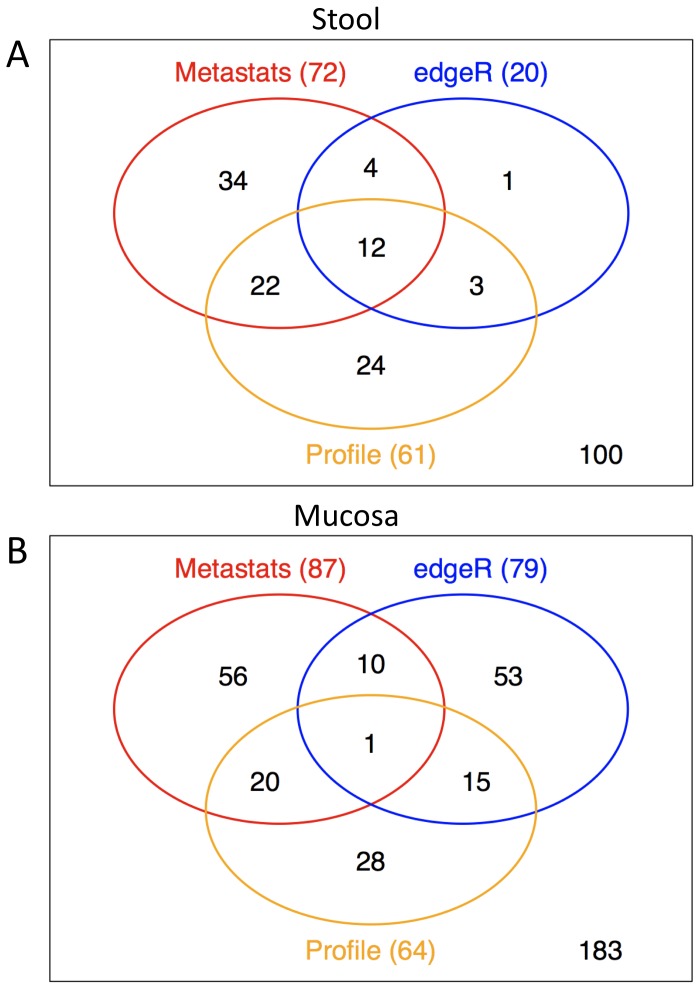
Consistency of measures.Congruence of Metastats, edgeR and Viz (denoted “Profile”; in at least two individuals simultaneously) for identification of significantly changing OTUs (diversity = 0.03) in stool samples (A) and mucosa samples (B).